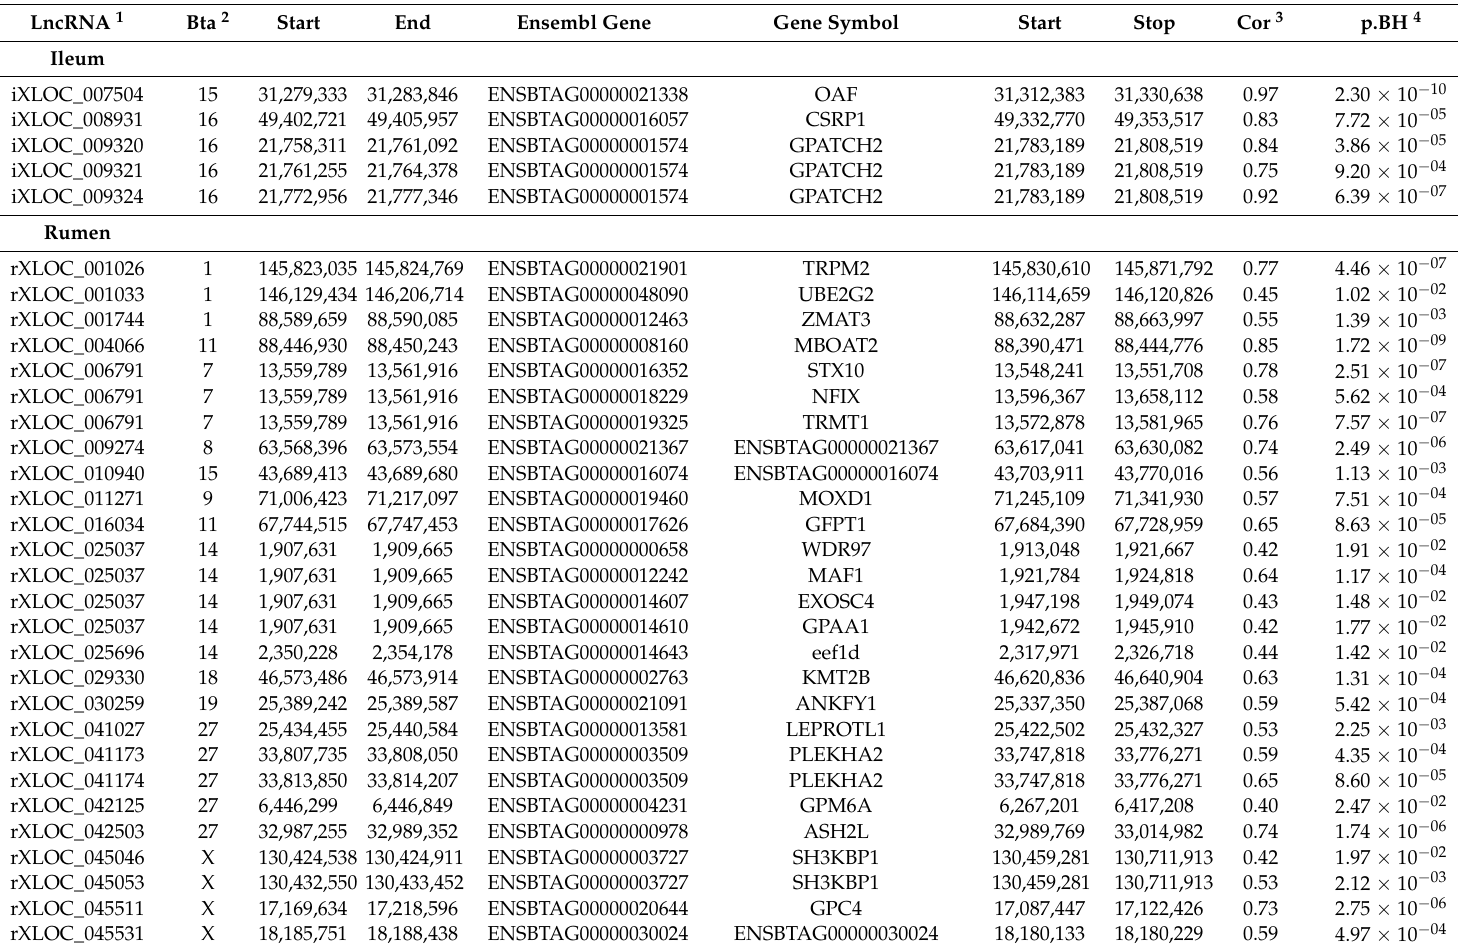
Table 3. Differentially expressed lncRNAs and their corresponding differentially expressed potential cis target genes in ileum and rumen